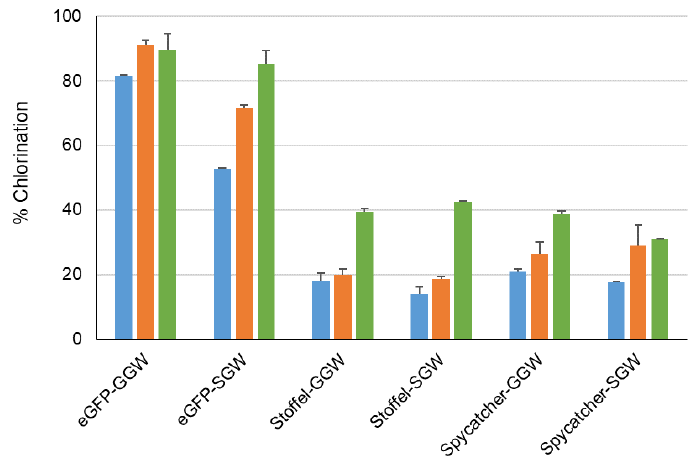
Figure 6. Chlorination of indicated proteins using WT PyrH (blue), PyrH-dASQV (orange) and PyrH-Q160N (green) mutants. Values represent average ± SD ( n = 2).